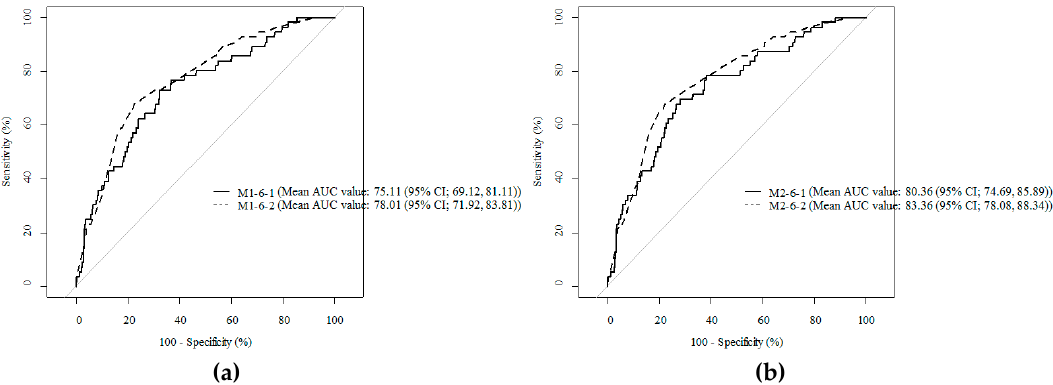
Figure 3. Receiver operating characteristic curve to compare performance of models to predict surgical site infection after gastrectomy by using 1000 bootstrap samples ( a : all surgical site infections; M1-6-1: visceral fat area to subcutaneous fat area as a continuous variable; M1-6-2: visceral fat area to subcutaneous fat area as a binary variable with cut-off point 0.94) ( b : organ/space surgical site infection; M2-6-1: visceral fat area to subcutaneous fat area as a continuous variable; M2-6-2: visceral fat area to subcutaneous fat area as a binary variable with a cut-off point of 0.94). Table 4. Diagnostic performance of model to predict surgical site infection after gastrectomy using visceral fat area to subcutaneous fat area as a binary variable. For model (using the binary variable) VFA-to-SFA cut-off value 0.94